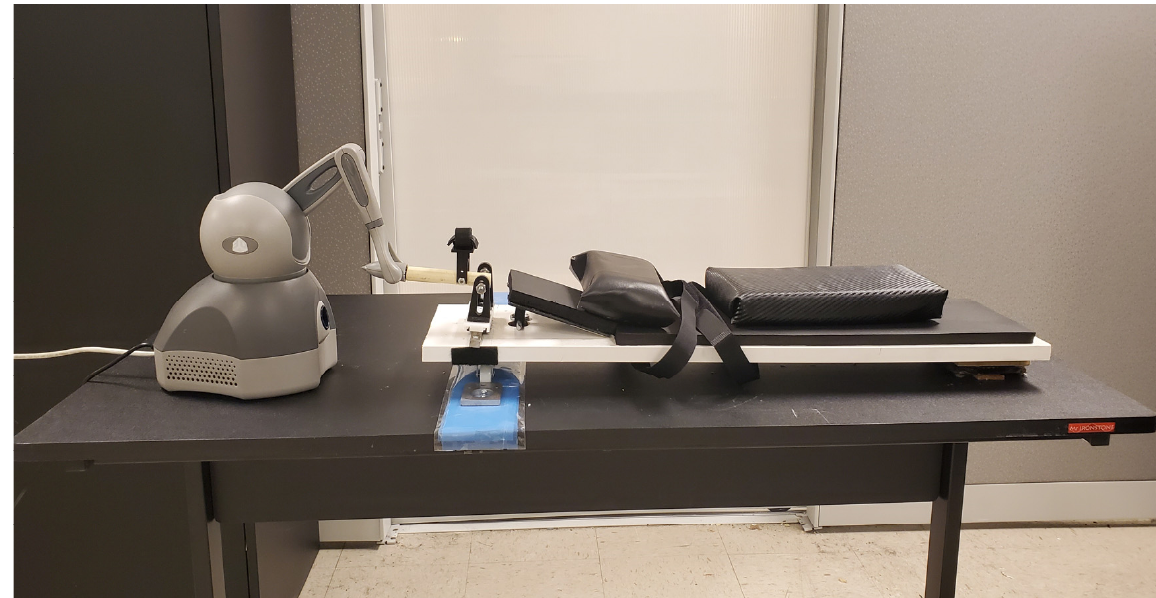
Figure 4. Custom-made portable arm restraint table setup.